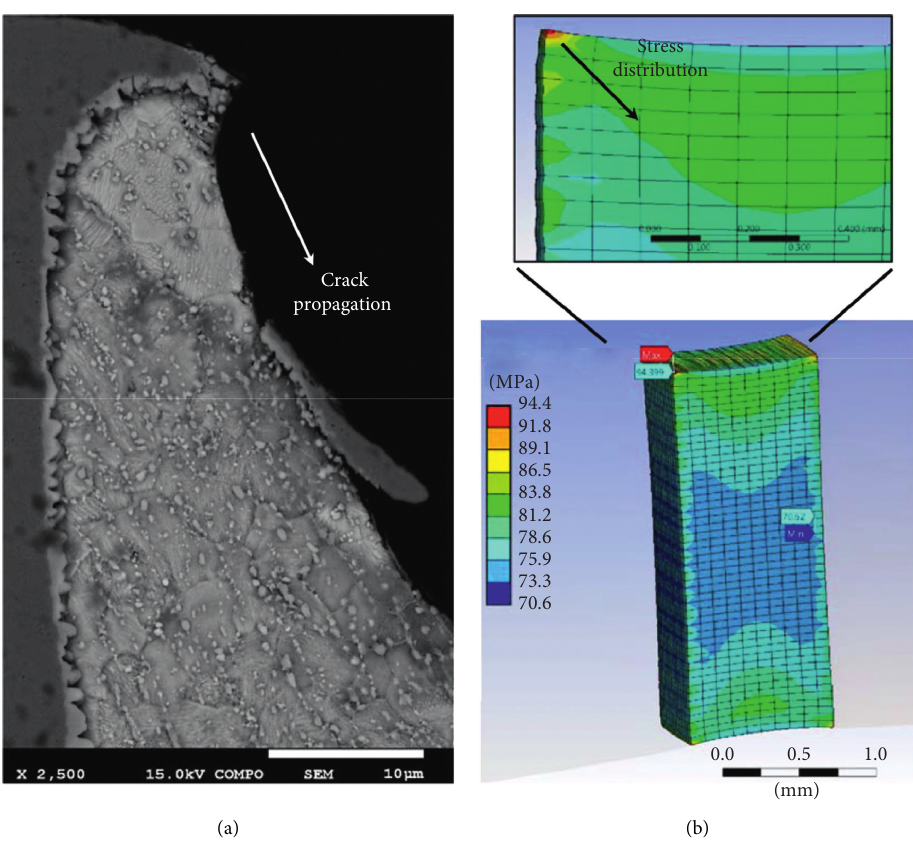
Figure 10: (a) Microstructure of the SAC108 joint soldered by induction heating; (b) FEM analysis of soldered joint area.